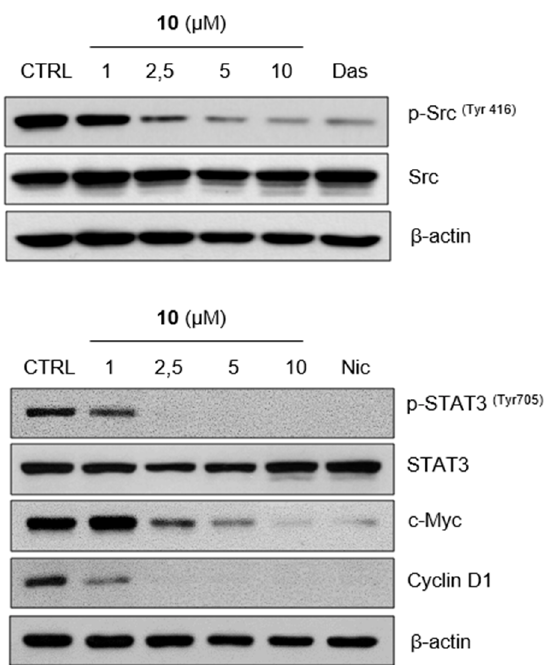
Figure 2. Compound 10 inhibits STAT3 signaling in breast cancer cells. MCF-7 cells were treated with compound 10 at indicated concentrations for 24 h. The levels of STAT3 and Src signaling pathway key players were detected by immunoblot analysis using appropriate antibodies. Samples treated by 20 µM of dasatinib (Das) or 10 µM of niclosamide (Nic) for 24 h were used as positive controls. Representative immunoblots of one out of three experiments are shown. CTRL, drug-free control.